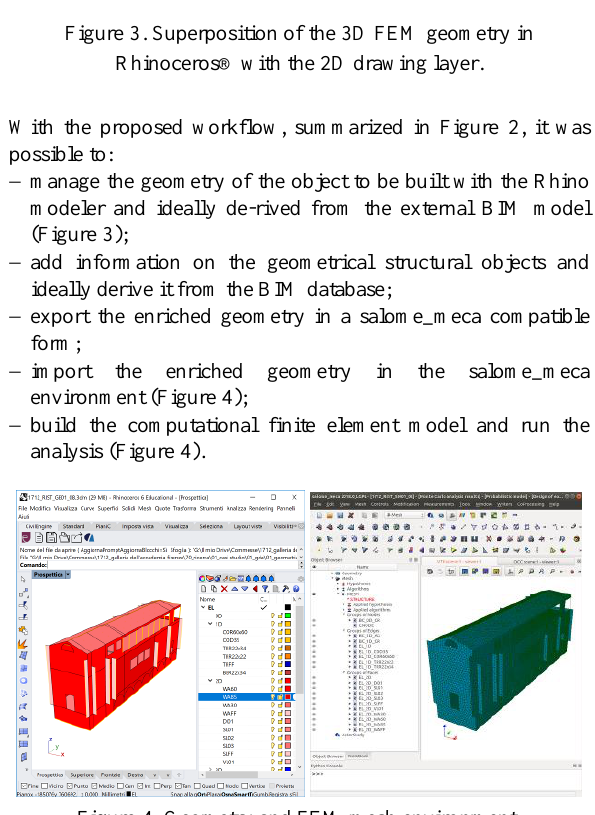
Figure 4. Geometry and FEM mesh